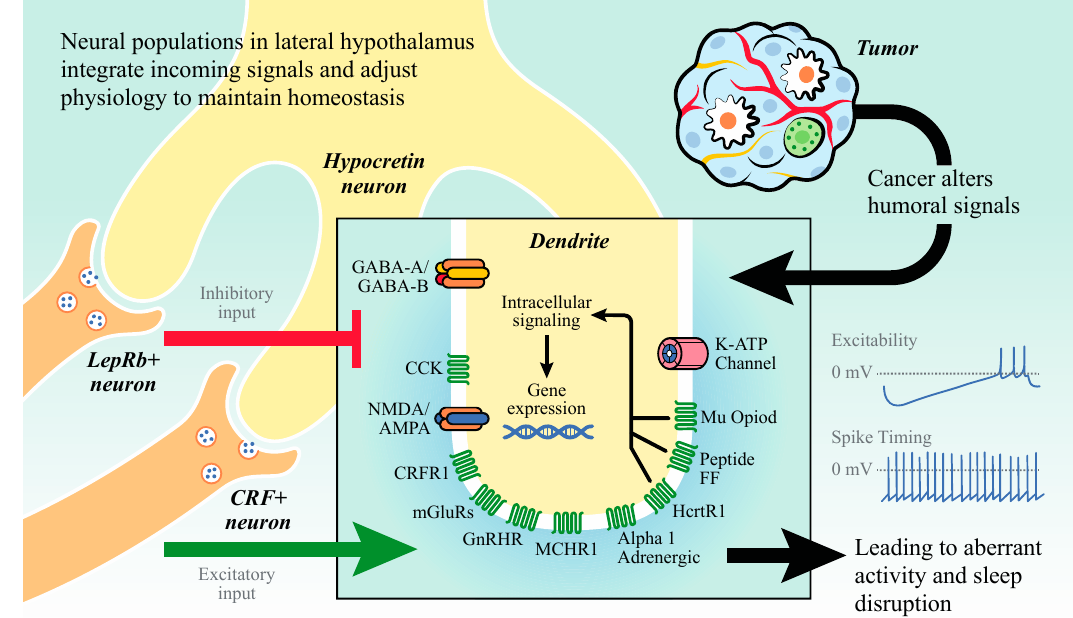
Figure 2. Discrete neural circuits integrate cancer-related neural and humoral signals arriving from the periphery. Depending on the timing and salience of these inputs, changes in gene expression and firing properties (e.g., spike timing) occur in an attempt to restore homeostasis. If this occurs chronically, it can influence systemic physiology and behavior resulting in debilitating symptoms like sleep and metabolic disruption.